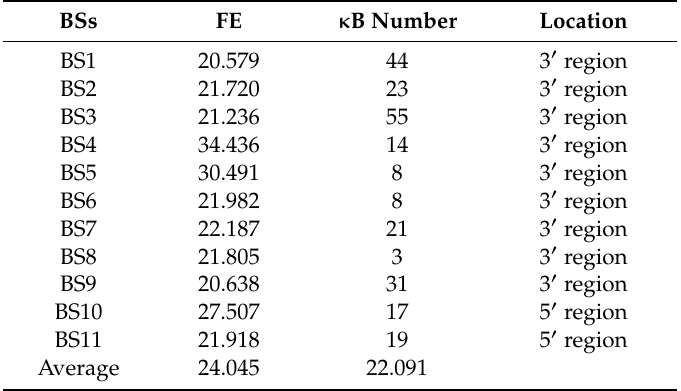
Table 1. Nuclear factor- κ B binding sites (NF- κ B-BSs) assigned to CASP9 and their κ B